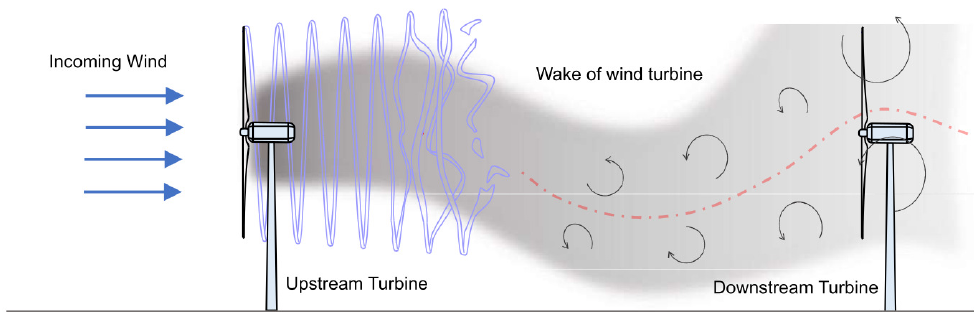
Figure 1. Wake of wind